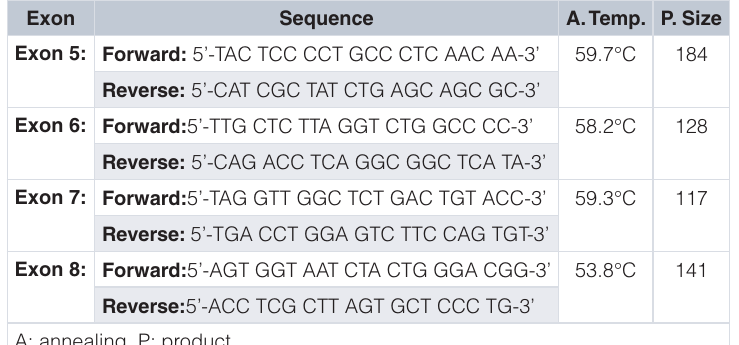
Table 1. Primer sets specifications.